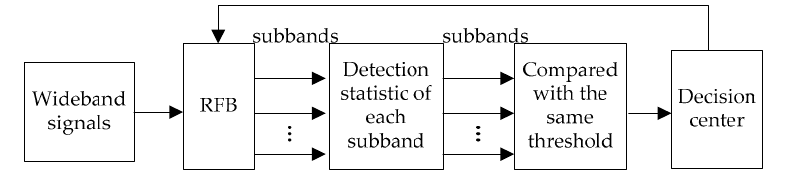
Figure 2. Wideband spectrum sensing with a RFB.